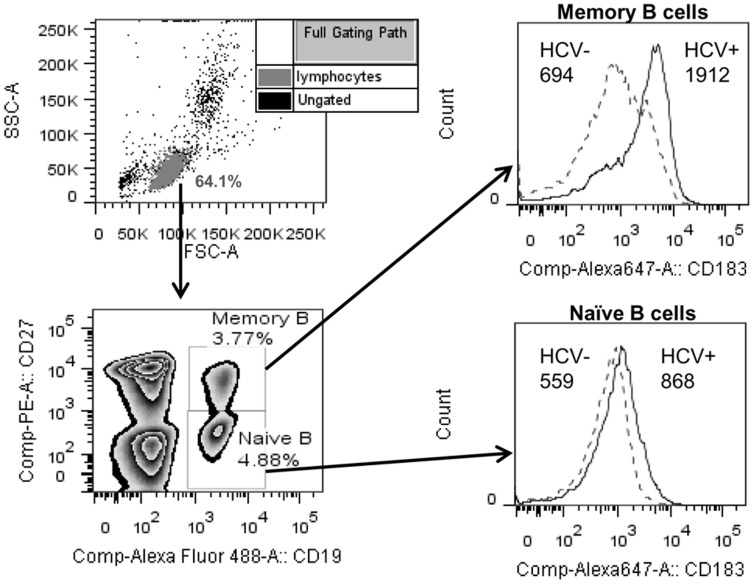
Gating strategy for flow cytometry analysis of memory and naïve B cell activation.Lymphocytes were gated by FSC/SSC properties and memory B cells (CD19+CD27+) and naïve B cells (CD19+CD27−) were analyzed within the lymphocyte gate for the expression of 6 different markers described in the Materials and Methods. Histograms show a representative example of the expression of CD183 (numbers represent geometric mean fluorescent intensity) on memory and naïve B cells from a healthy control (HCV-) and chronic HCV patient (HCV+).